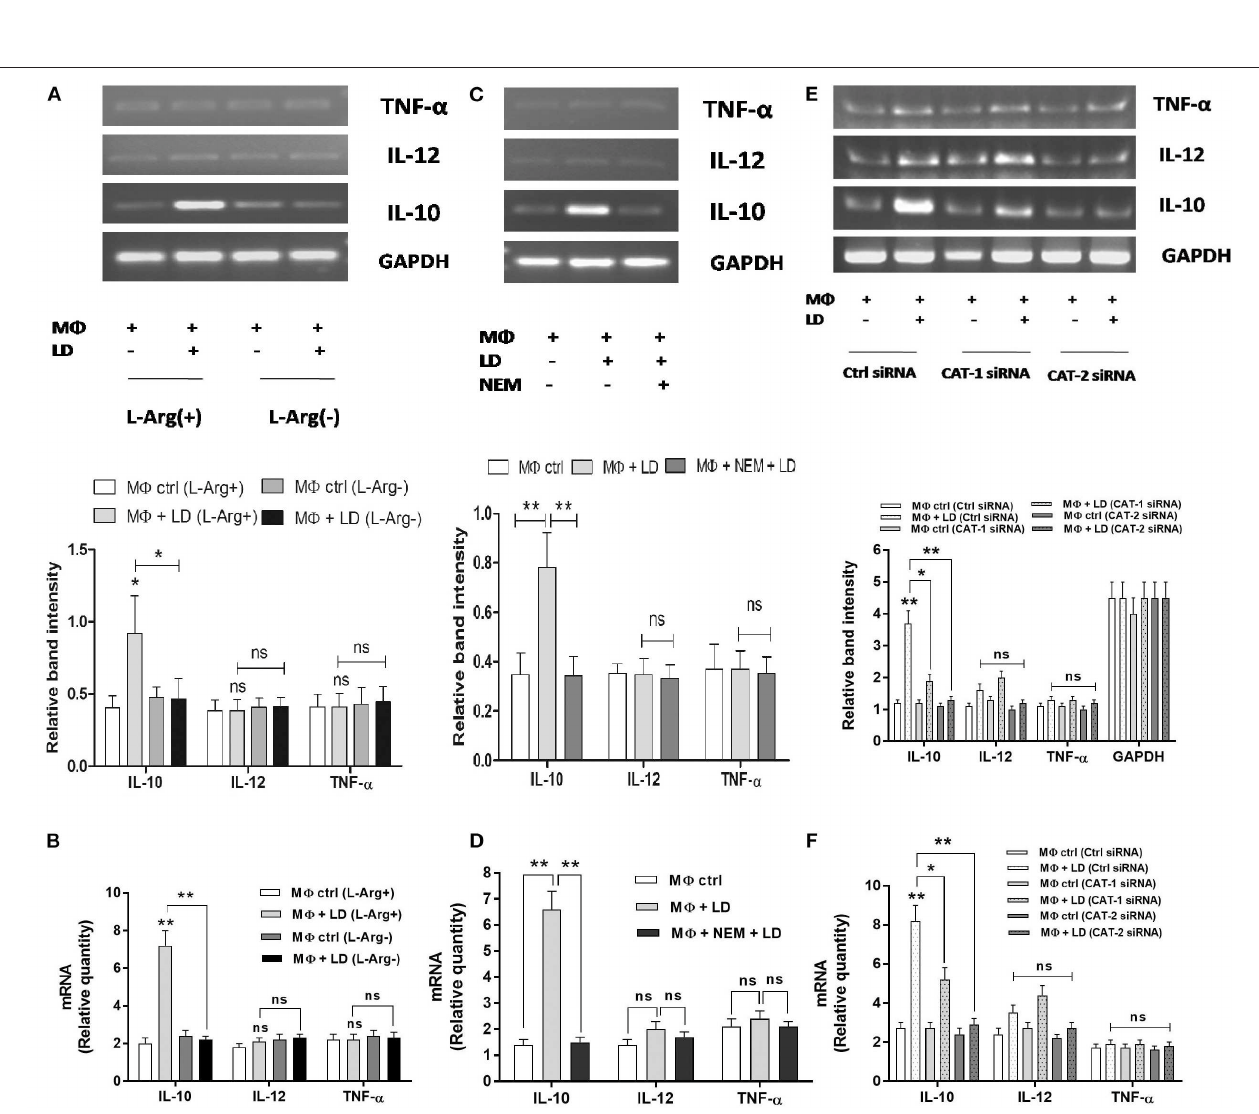
FIGURE 10 | measured by counting the number of intracellular amastigotes per 100 macrophages (A,C) . The rate of infection was analyzed by counting the percent infected macrophages (B,D) . Extracellular nitrite level was measured by Griess method using NaNO 2 as standard (E,F) . The polyamines (putrescine and spermidine) were extracted by TCA precipitation followed by dansyl chloride derivatization, separation by reverse-phase high performance liquid chromatography as described in “Materials and Methods.” Dansylated putrescine (G,I) and dansylated spermidine (H,J) were quantified by fluorescence spectrometry. Each experiment was repeated three times. Each determination was made in triplicate and the values were expressed as mean ± SD for three independent experiments. Kruskal–Wallis with Dunn’s multiple comparison test was used to evaluate statistical significance for comparing three or more groups; * p < 0.05; ** p < 0.005; ns, non-significant.